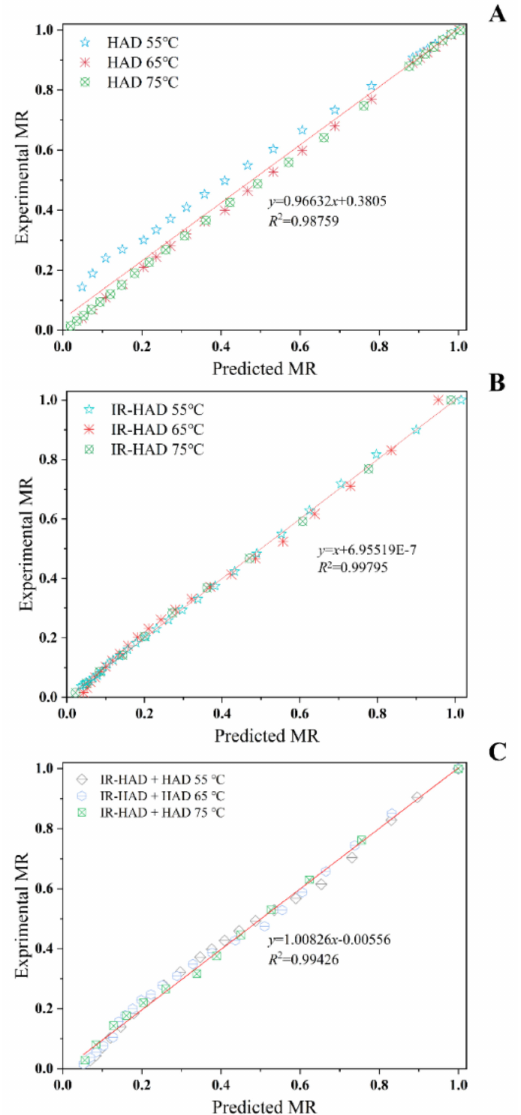
Figure 4. Predicted moisture ratio by Logarithmic model ( A ) versus experimental moisture ratio under hot air drying (HAD); predicted moisture ratio by Logarithmic model ( B ) versus experimental moisture ratio under combined infrared and hot air drying (IR-HAD); and predicted moisture ratio by Page model ( C ) versus experimental moisture ratio under sequential IR-HAD and